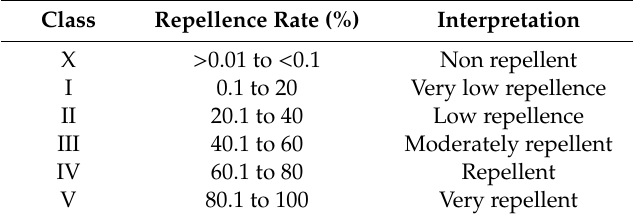
Table 1. Interpretation of Percentage